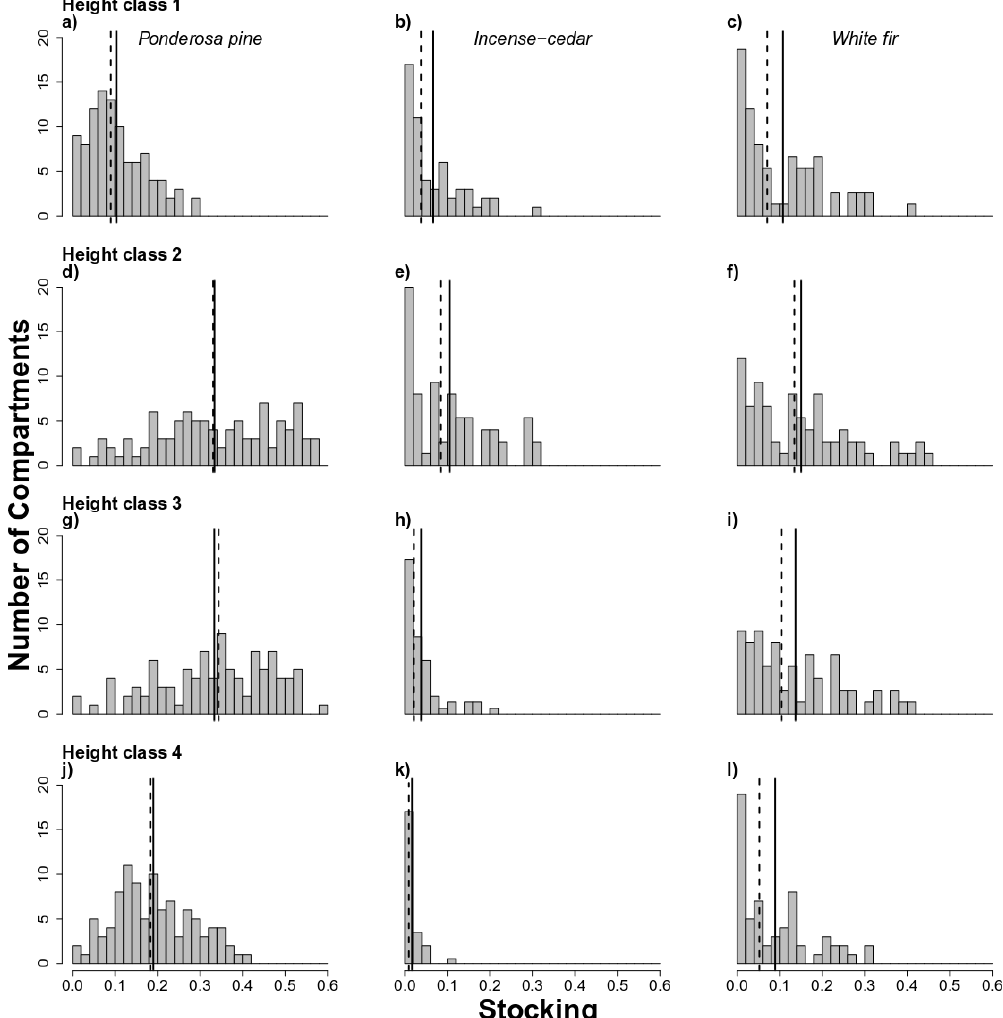
Figure 4. Histograms of 1935 stocking proportion at 0.0016 ha for 100 compartments by four